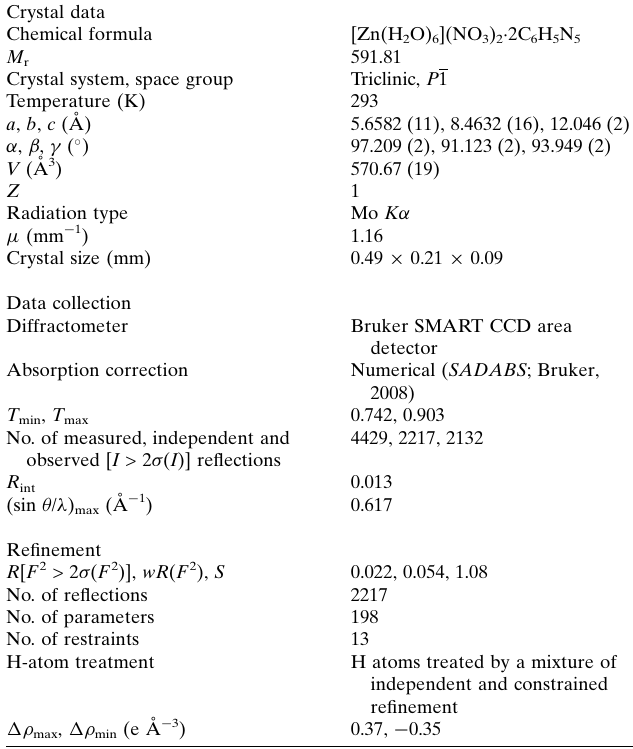
Table 4 Experimental